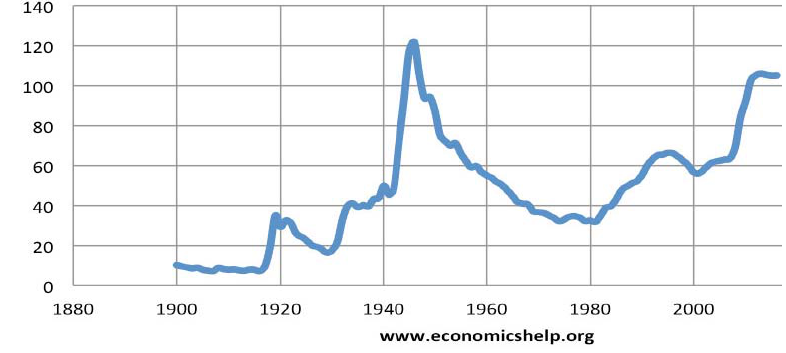
Fig. 1. Federal debt to GDP ratio forthe United States